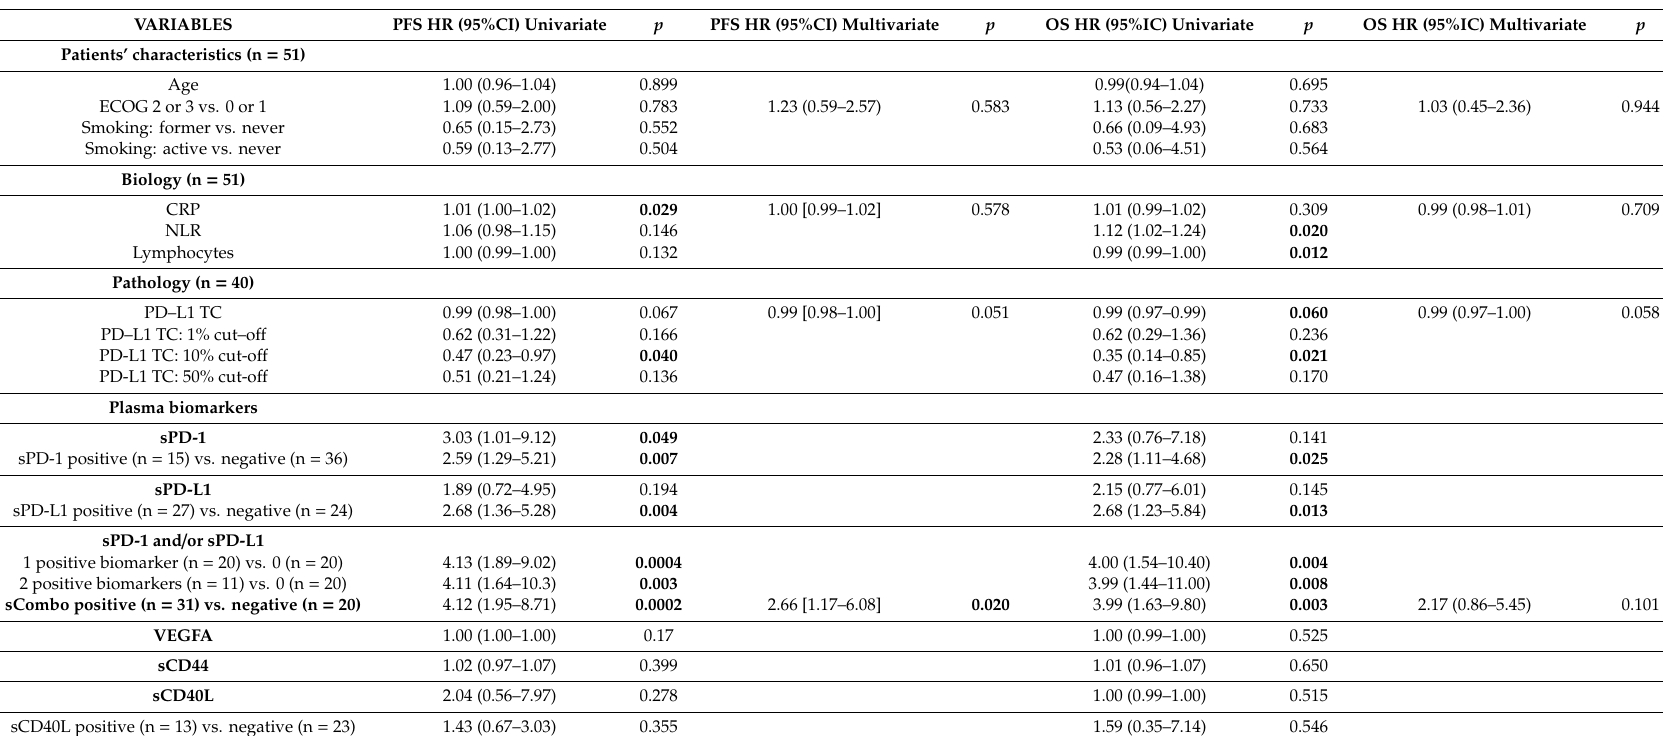
Table 2. Univariate and multivariate Cox proportional hazard analyses of progression-free survival (PFS) and overall survival (OS) according to baseline plasma biomarker expression among patients treated with